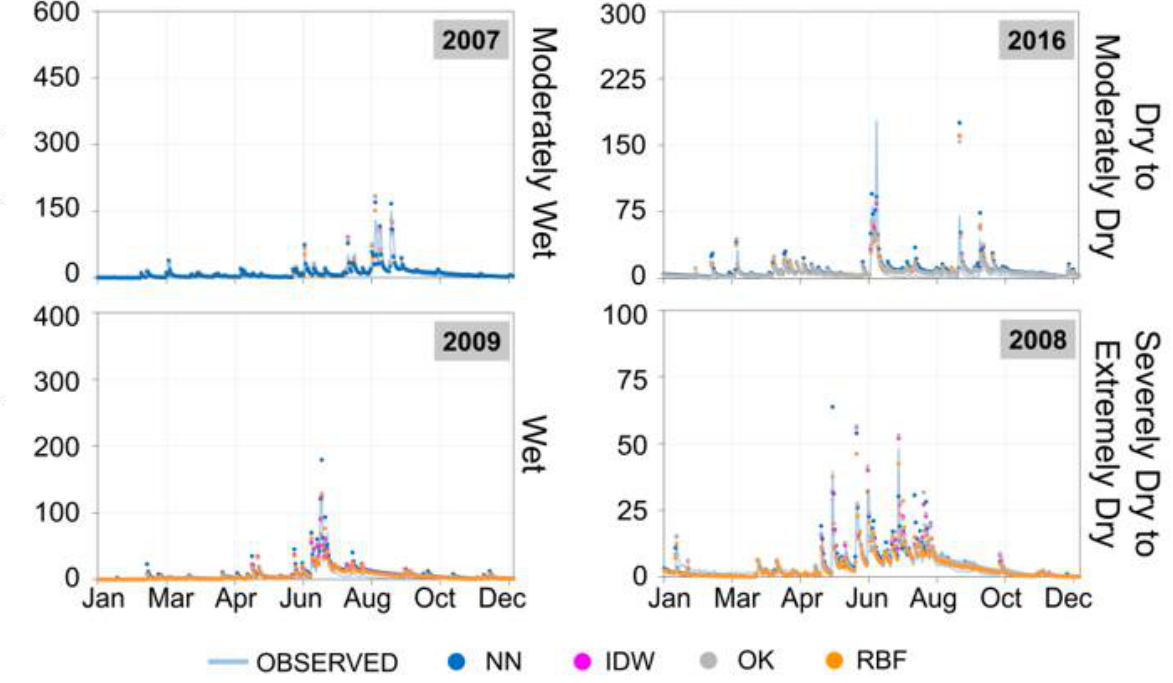
Figure 9. Optimal interpolation method based on long-term meteorological conditions at the Yongdam watershed (NN for moderately wet, OK or IDW for dry to moderately dry, and RBF for wet or severely dry to extremely dry conditions).